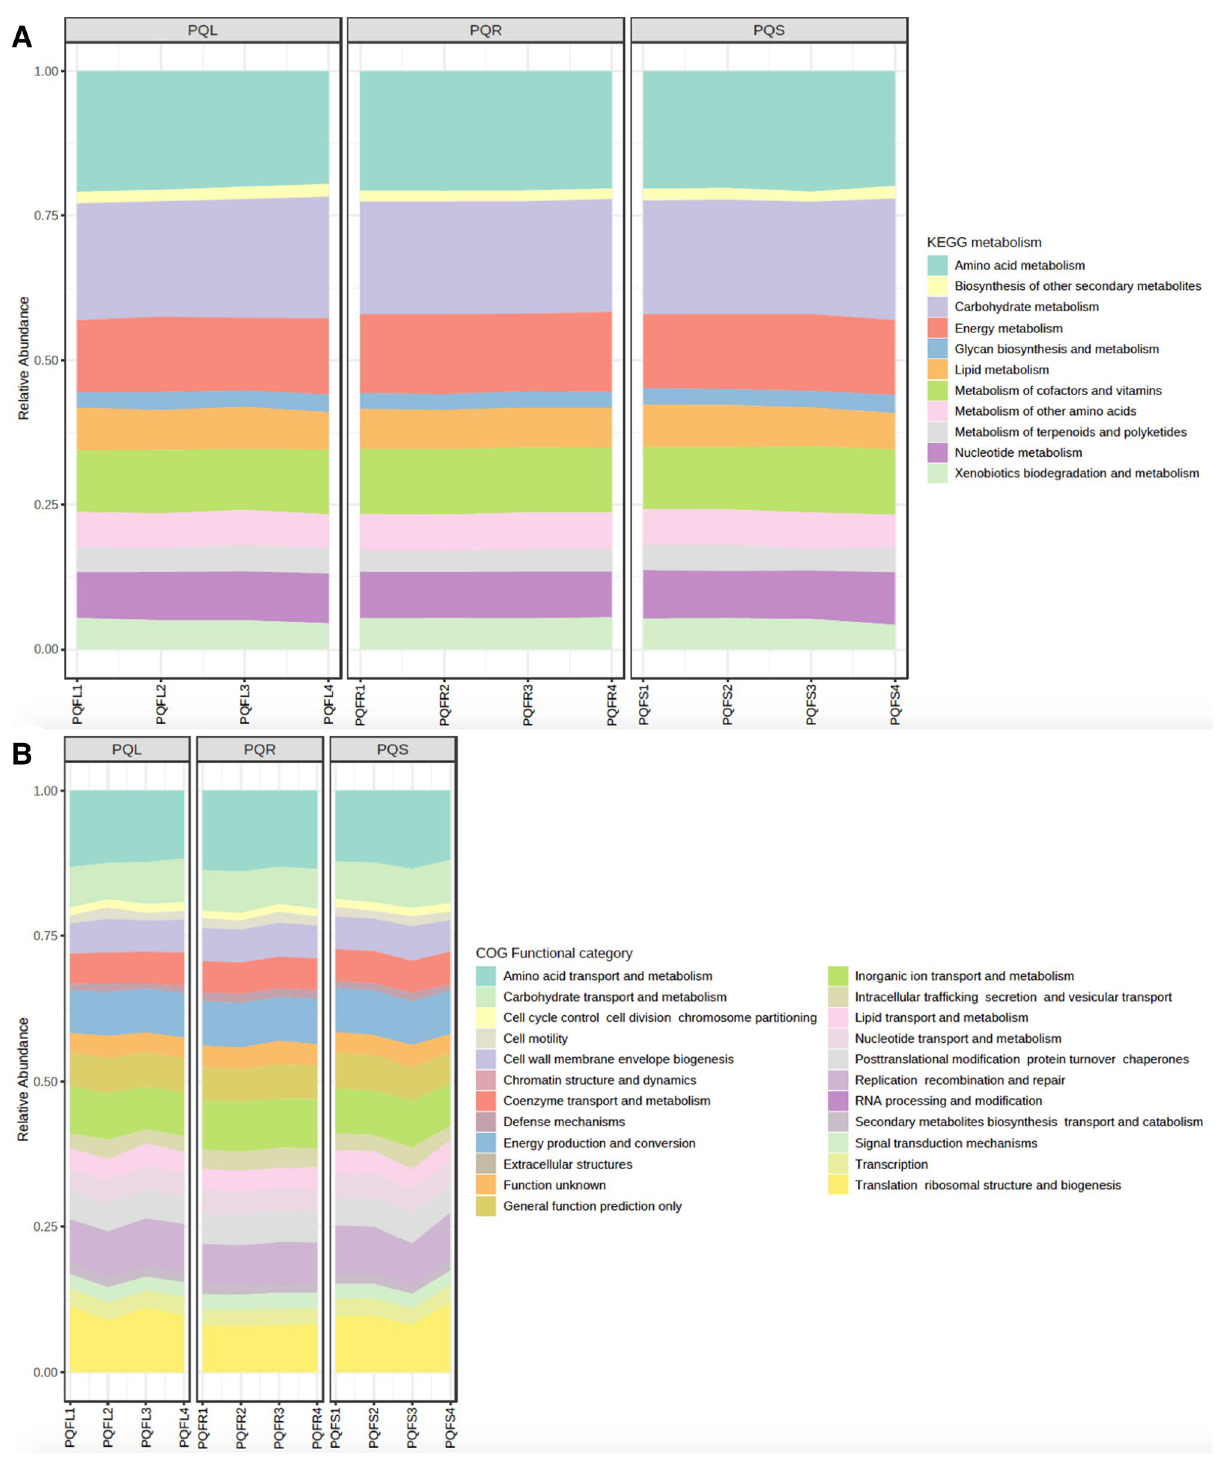
Figure 10. Prediction of functional pathways of Panax quinquefolius associated bacterial communities. ( A ) Kyoto Encyclopedia of Genes and Genomes (KEGG) metabolism and ( B ) Clusters of Orthologous Groups of proteins (COG) functional